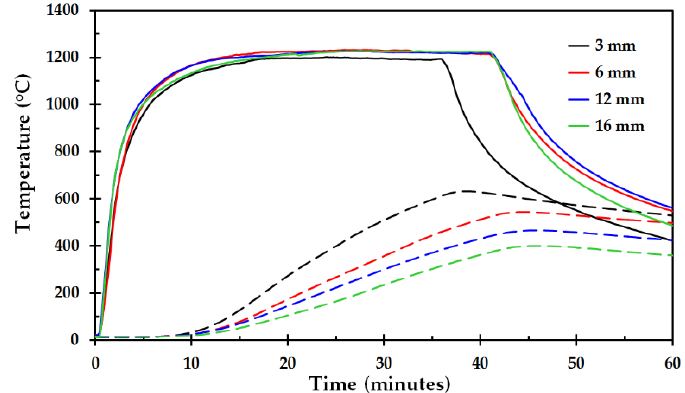
Figure 9. Comparison of 3, 6, 12 and 16 mm steel plate. Every plate thickness represents an average of